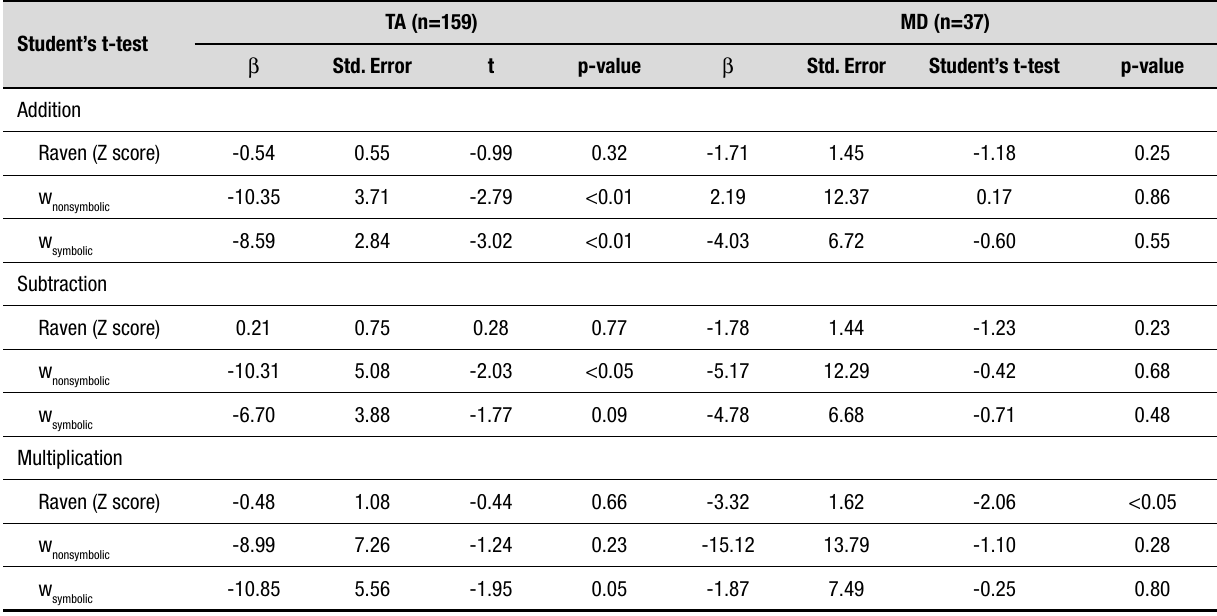
Table 3. Regression